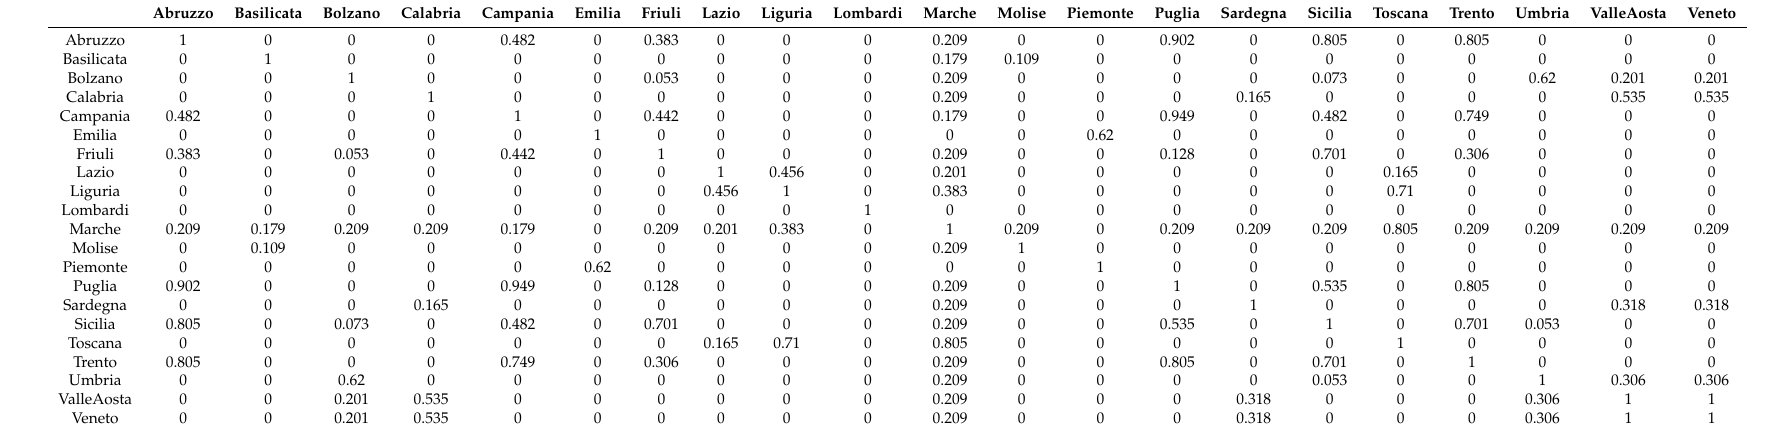
Table A17. Similarity values of Total Hospitalized network in the fourth week.